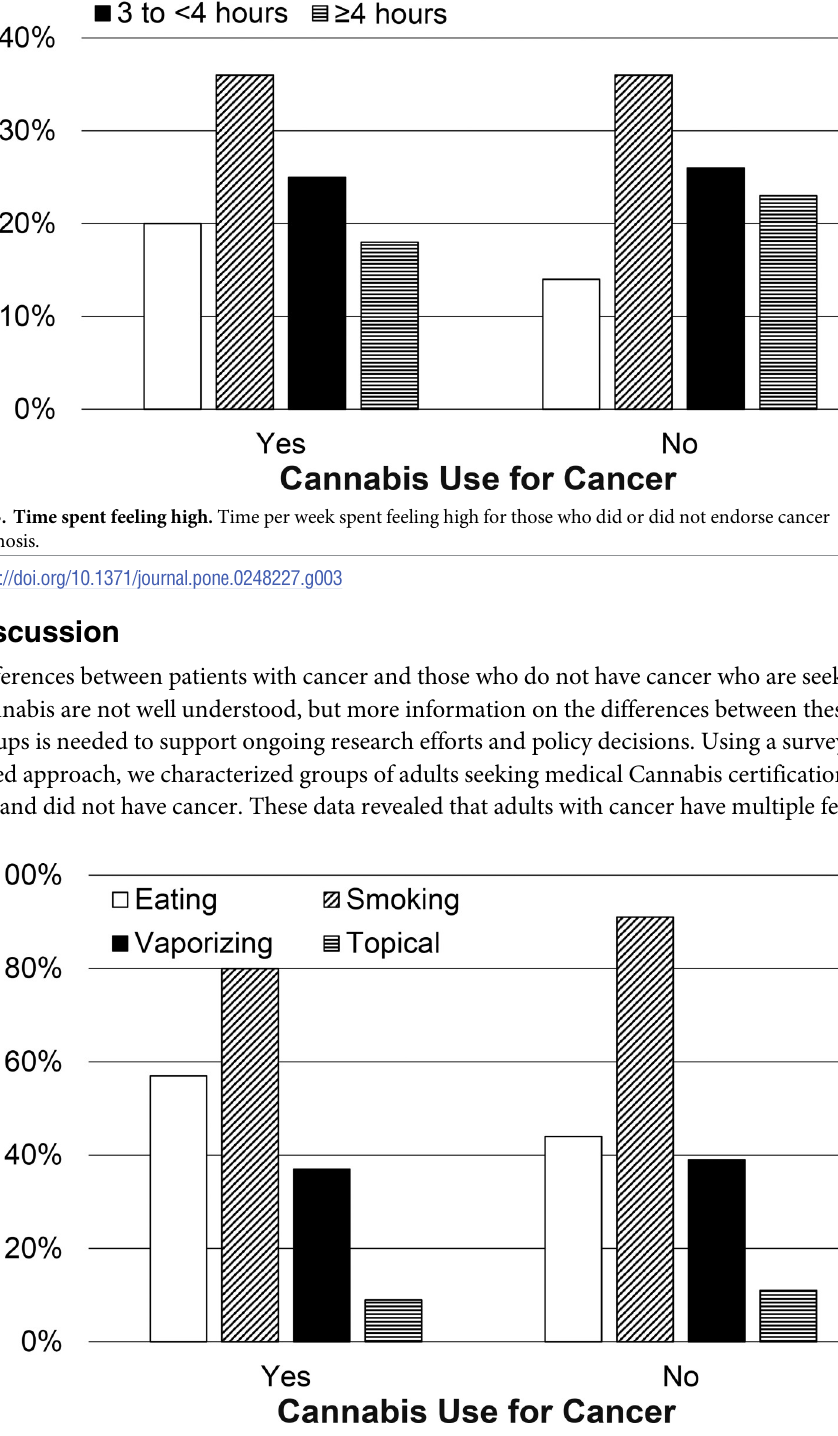
Fig 4. Cannabis mode of administration. Mode of Cannabis administration endorsed by individuals with and without